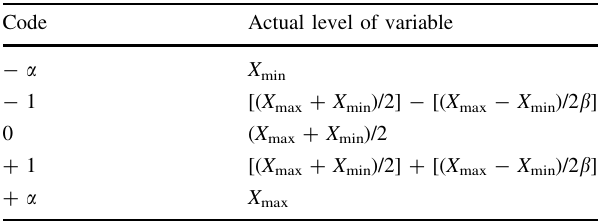
Table 1 Relationship between coded and actual value of the variables Code